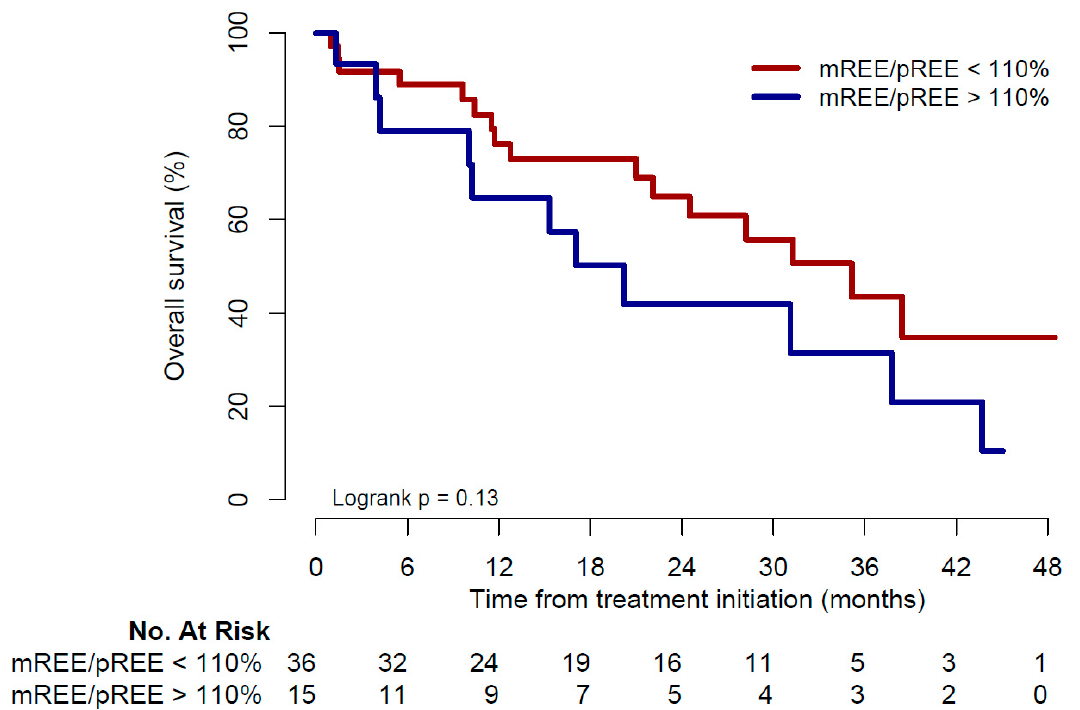
Figure 3. Kaplan–Meier curve for overall survival. mREE: measured resting energy expenditure; pREE: predicted resting energy expenditure.